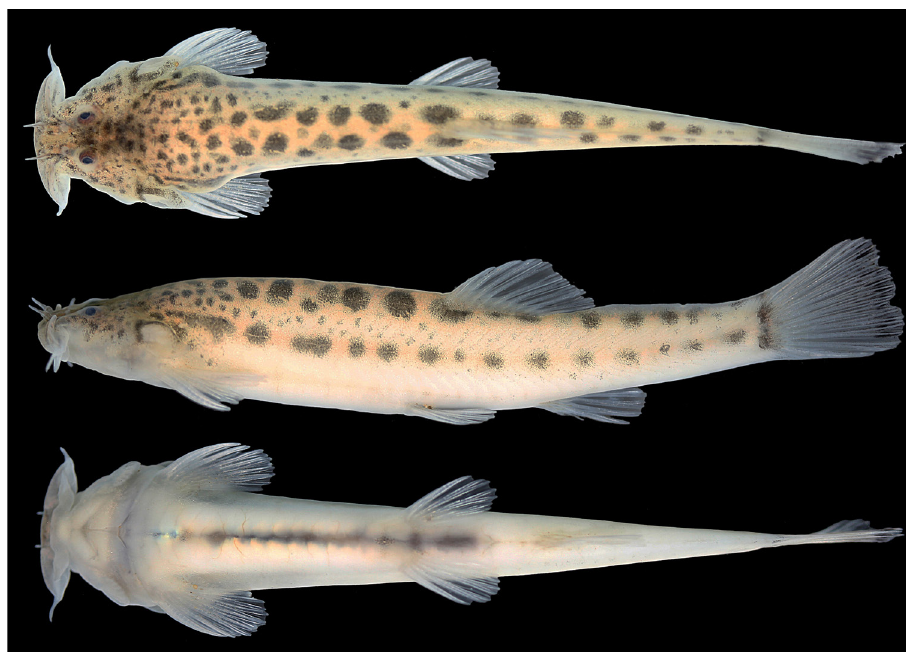
FIGURE 22 | Specimen in life of Scleronema operculatum (UFRGS 18086; 42.3 mm SL), Brazil, Rio Grande do Sul, Rosário do Sul, sanga Santo Antônio, tributary to rio Ibicuí da Armada, lower rio